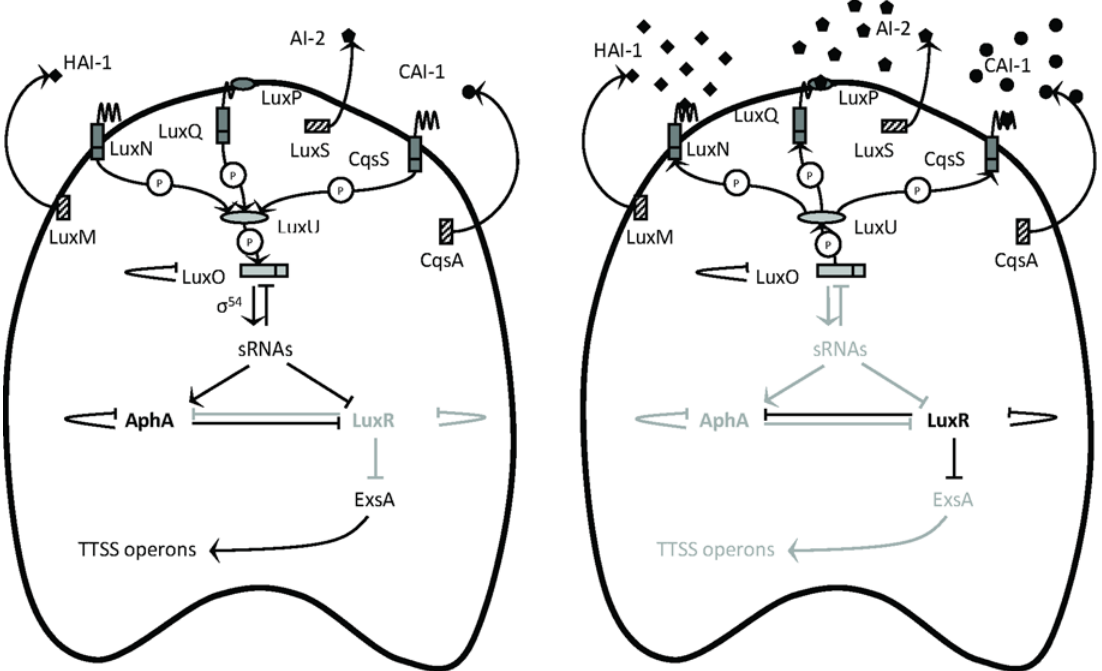
Fig 1. Quorum sensing in Vibrio harveyi . The LuxM, LuxS and CqsA enzymes synthesise the signal molecules HAI-1, AI-2 and CAI-1, respectively. These signal molecules are detected at the cell surface by the LuxN, LuxQ and CqsS two-component receptor proteins, respectively. Detection of AI-2 by LuxQ requires the periplasmic protein LuxP. (A) In the absence of signal molecules, the receptors autophosphorylate and transfer phosphate to LuxO via LuxU. Phosphorylation activates LuxO, which together with σ 54 activates the production of five small regulatory RNAs (sRNAs). These sRNAs, together with the chaperone Hfq, destabilise the mRNA encoding the transcriptional regulator LuxR. Therefore, in the absence of autoinducers, the LuxR protein is not produced. LuxR is a repressor of ExsA. Hence, in the absence of signal molecules, ExsA is produced and in turn activates expression of the TTSS operons. (B) In the presence of high concentrations of the signal molecules, the receptor proteins switch from kinases to phosphatases, which results in dephosphorylation of LuxO. Dephosphorylated LuxO is inactive and therefore, the sRNAs are not formed and the transcriptional regulator LuxR is produced. LuxR represses ExsA, and the TTSS operons are not expressed. “ P ” denotes